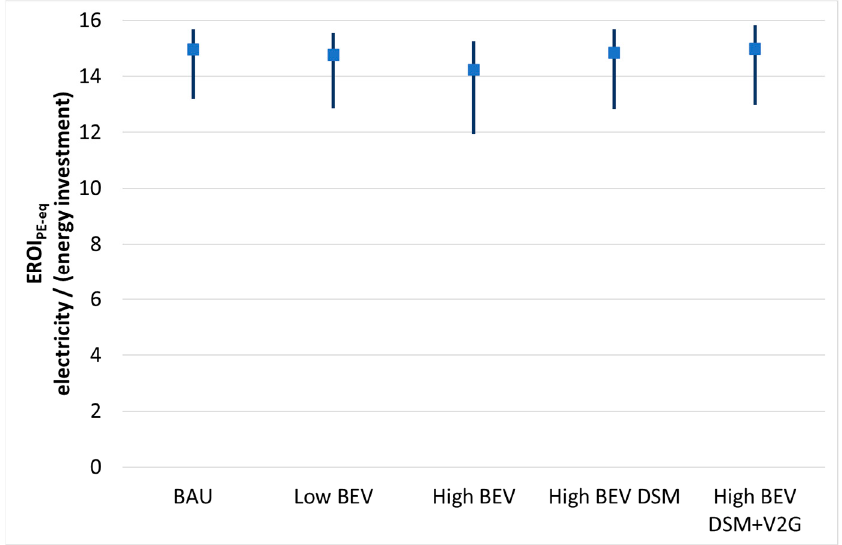
Figure 10. Energy return on investment (EROI PE-eq ) of electricity supplied by the domestic grid, with sensitivity analysis to Li-ion battery lifetime (baseline = 20 years, worst case = 10 years, best case = 30 years). The PE-eq conversions are based on the grid efficiencies reported in Figure 5 (~0.7).